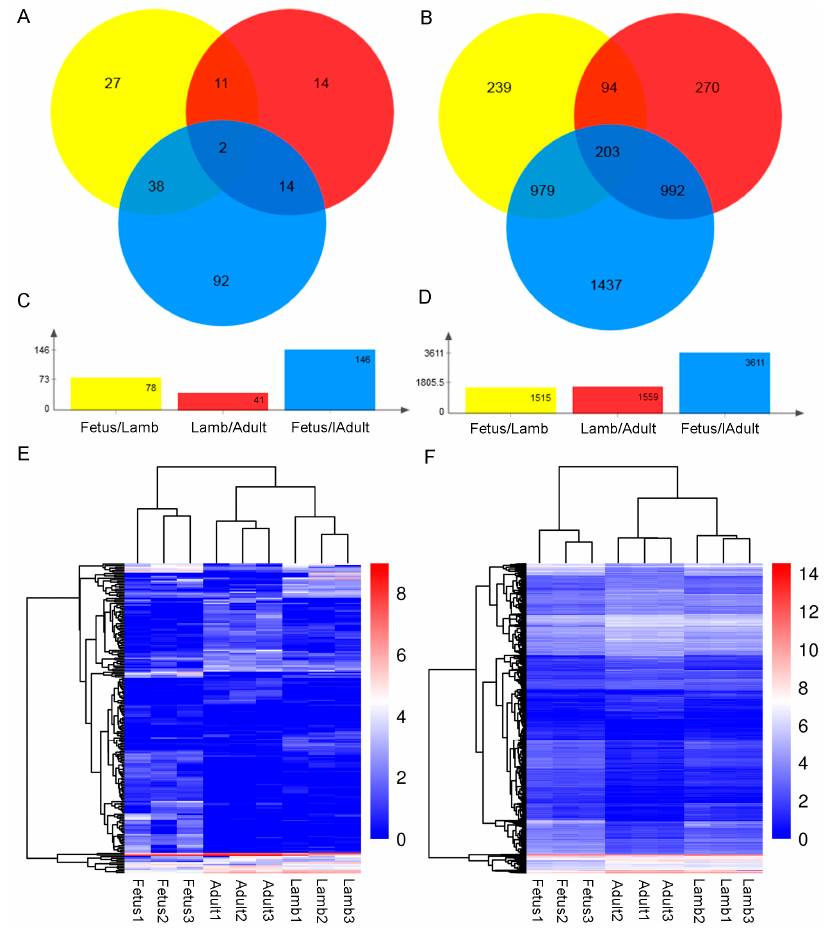
Figure 4. The number of differentially expressed lncRNAs and differentially expressed genes (DEGs) in (control/experiment) fetus/lamb, lamb/adult and fetus/adult comparisons. ( A ) Venn diagram of the number of differentially expressed lncRNAs among different comparisons. ( B ) Venn diagram of the number of DEGs among different comparisons. ( C ) Total number of differentially expressed lncRNAs in each comparison. ( D ) Total number of DEGs in each comparison. ( E ) The hierarchical cluster of differentially expressed lncRNAs. ( F ) The hierarchical cluster of DEGs.